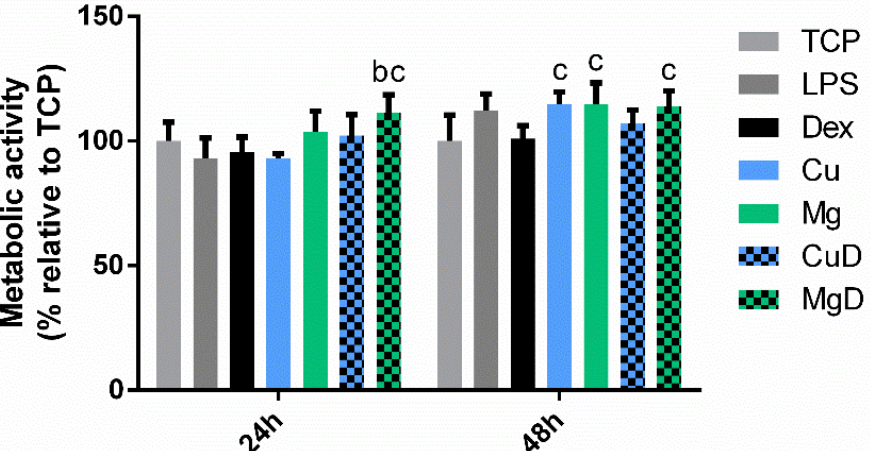
Figure 1. Effect of dex and the combination of dex with Cu 2+ and Mg 2+ on THP-1 cell metabolic activity. THP-1 cells were cultured with Cu 2+ and Mg 2+ ions (Cu and Mg, respectively), as well as with a combination of dex with Cu 2+ (CuD) and Mg 2+ (MgD) for 24 and 48 h. Metabolic activity results were represented as percentage relative to an unstimulated control (TCP) and compared with the TCP of each day. Statistically significant differences compared to TCP, LPS and dex were indicated with b and c, respectively ( p < 0.05).